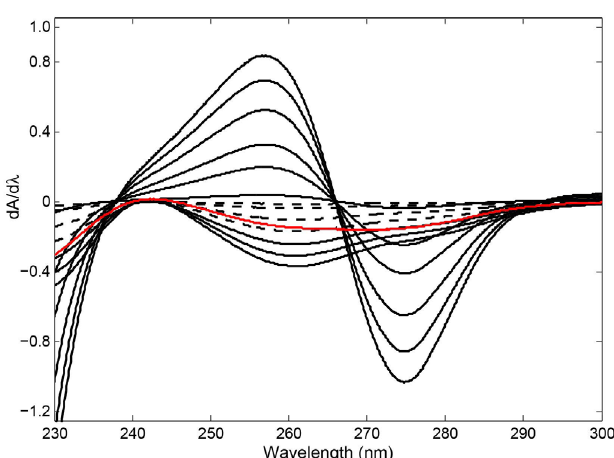
FIGURE 5 - First derivative spectra of VAL (----) : 1.0, 3.0, 9.0, 15.0, 21.0, 27.0, 33.0 µ g/mL and HCT (  ) : 1.0, 6.0, 11.0, 16.0, 21.0, 26.0 µ g/mL and tablet sample (  ) containing 2.50 µ g/mL of VAL and 16.0 µ g/mL of HCT.